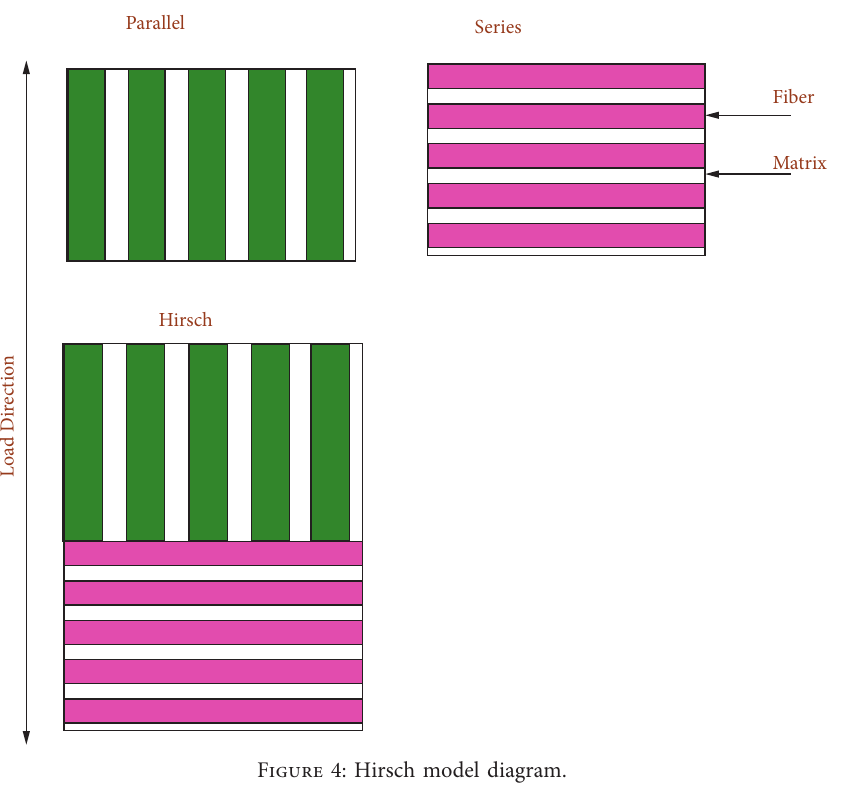
Figure 4: Hirsch model diagram.